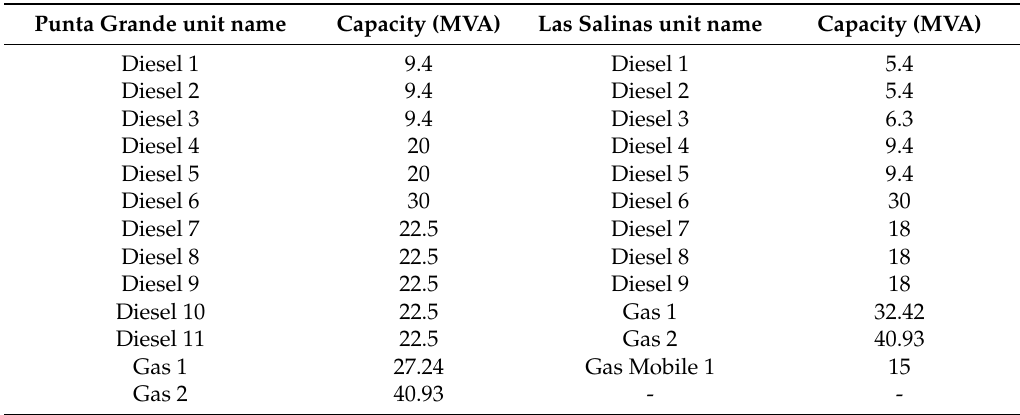
Table 1. Conventional generation